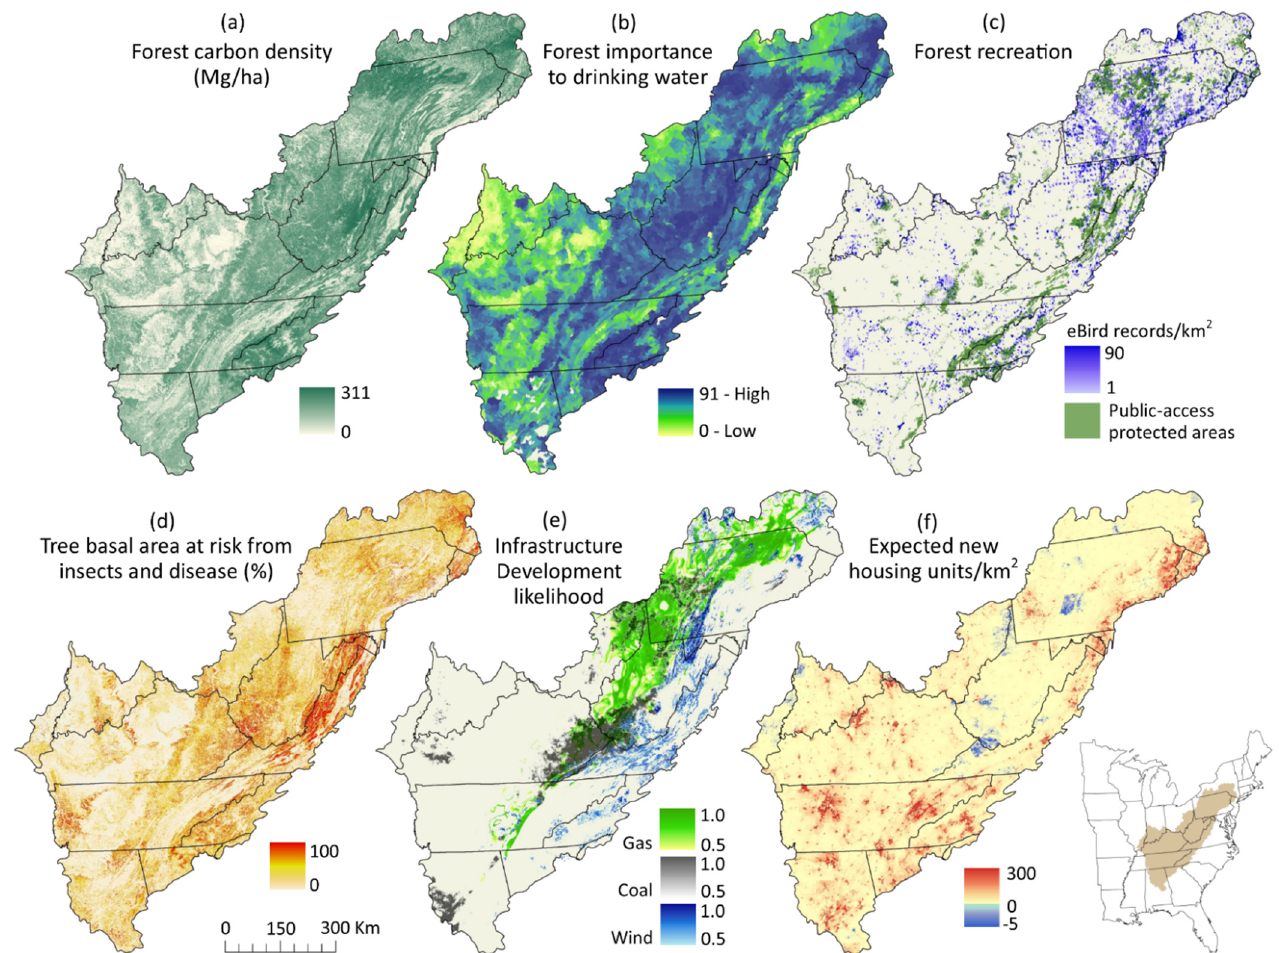
Figure 4. Examples of ecosystem service ( a – c ) and stressor ( d – f ) distributions across the ALCC region. Inset shows the ALCC location in the eastern United States. ( a ) Total forest stored carbon density (Mg/ha), 2000–2009 [60]. ( b ) Importance of forests for drinking water supply [61]. ( c ) Forest recreational uses: protected natural areas with public access, and density of citizen science observations of a common forest bird group (Vireo spp.) from 2003 to 2012 (observations/km 2 ) [62,63]. ( d ) Expected composite risk of forest tree mortality from insects and disease, 2013–2027 (% of basal area) [64]. ( e ) Expected likelihood of infrastructure build-out for gas, coal, or wind energy extraction by 2035 [65,66]. ( f ) Expected change in housing density, 2010–2030 (units/km 2 ) [67].